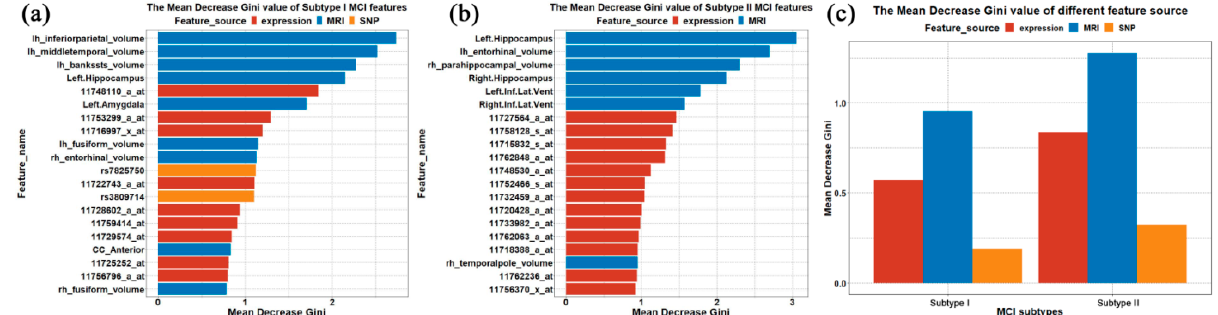
Figure 3. Distribution of mean decrease in Gini coefficient. ( a , b ) Gini coefficient of top 20 important features of subtype I and II classifier models. Vertical coordinate indicates name of each feature and horizontal coordinate indicates mean decrease in Gini coefficient. Colors indicate feature sources: red, gene expression; blue, sMRI; yellow, SNP. ( c ) Average Gini coefficient for each feature source in subtypes I and II. Vertical coordinate indicates average Gini coefficient for feature sources of important features of subtype I and II classifier models. Horizontal coordinate indicates MCI subtypes.